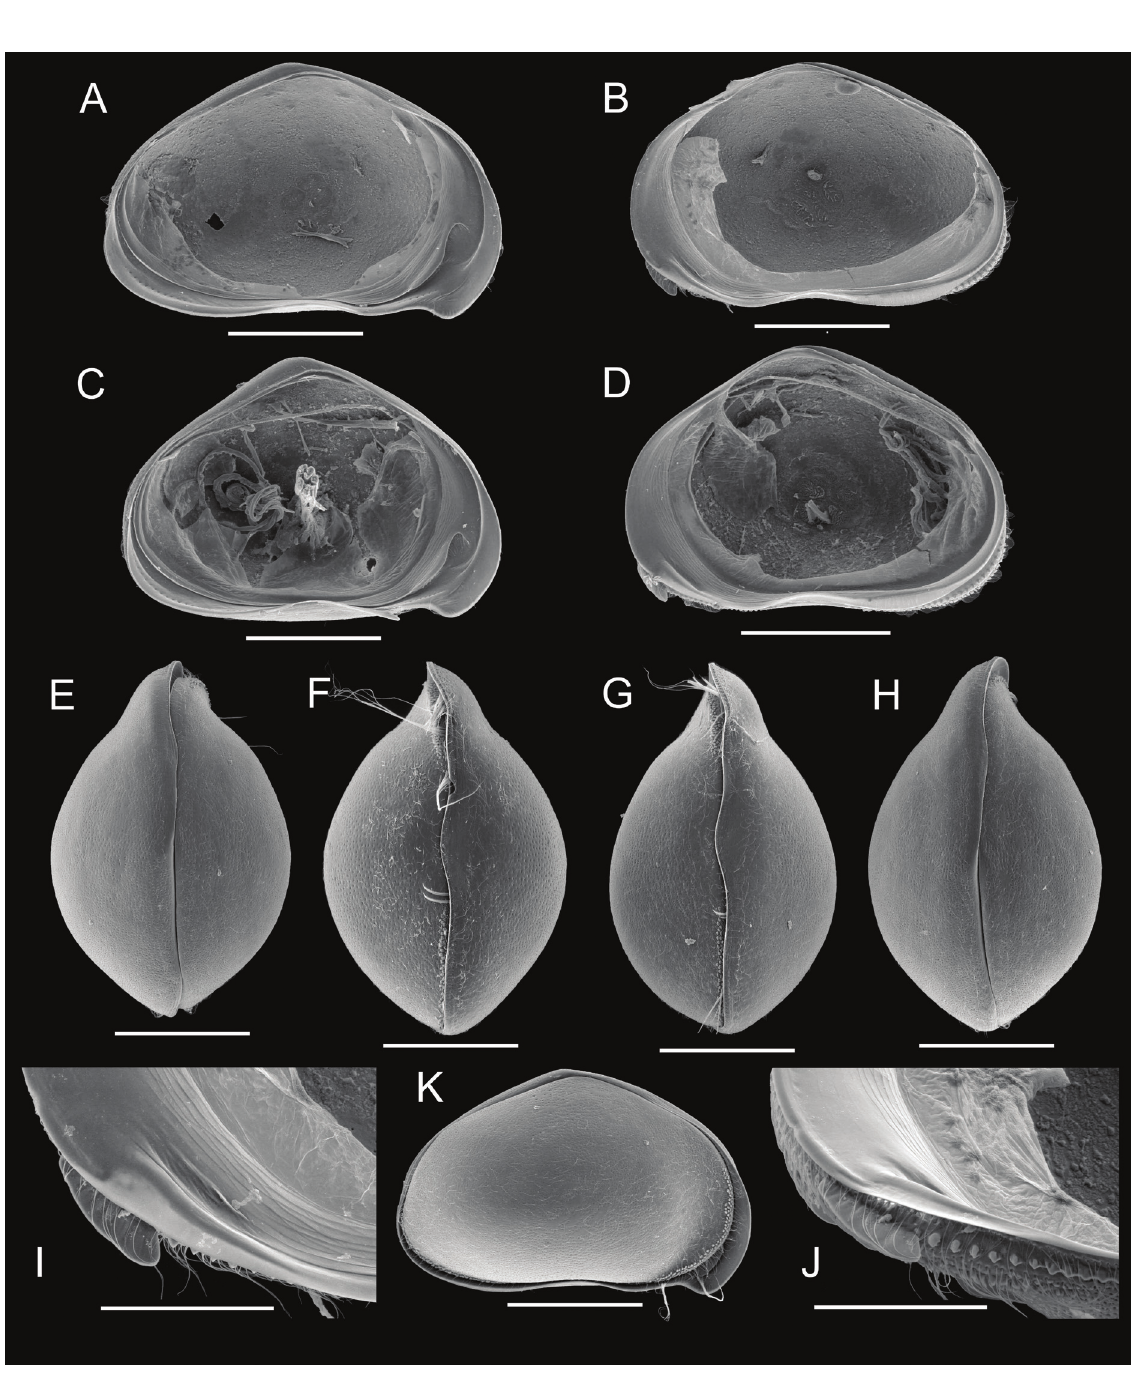
Fig. 10. Bennelongia frumenta sp. nov. A . LVi (holotype ♀, Kodjinup Melaleuca Swamp, WAM.C49380). B . RVi (♀, Kodjinup Melaleuca Swamp, Idem). C . LVi (♂, West Kulunilup Swamp, OC.3313). D . rVi (♂, West Kulunilup Swamp, Idem). E . Cp dorsal (♀, Kodjinup Melaleuca Swamp, WAM.C49383). F . Cp ventral (♀, Kodjinup Melaleuca Swamp, WAM.C49388). G . Cp ventral (♂, West Kulunilup Swamp, WAM.C49382). H . Cp dorsal (♂, Kodjinup Melaleuca Swamp, WAM.C49382). I . rVi (detail anteriorly, holotype ♀, Kodjinup Melaleuca Swamp, WAM.C49380). J . rVi (detail anteriorly, ♀, Kodjinup Melaleuca Swamp, Idem). K . CpRe (♀, Kodjinup Melaleuca Swamp, WAM.C49383). Scales: A-H, K = 500 µm; I-J = 200